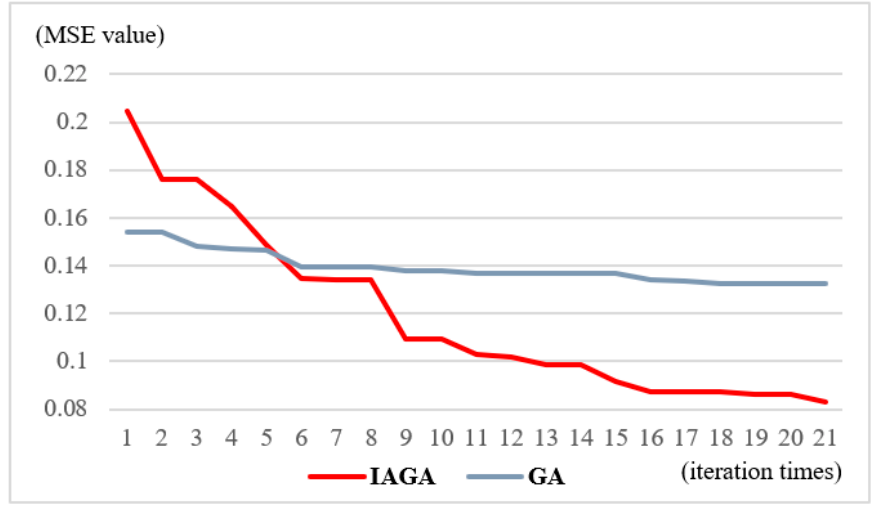
Figure 7. The comparison result of iterative efficiency using IGA and GA.